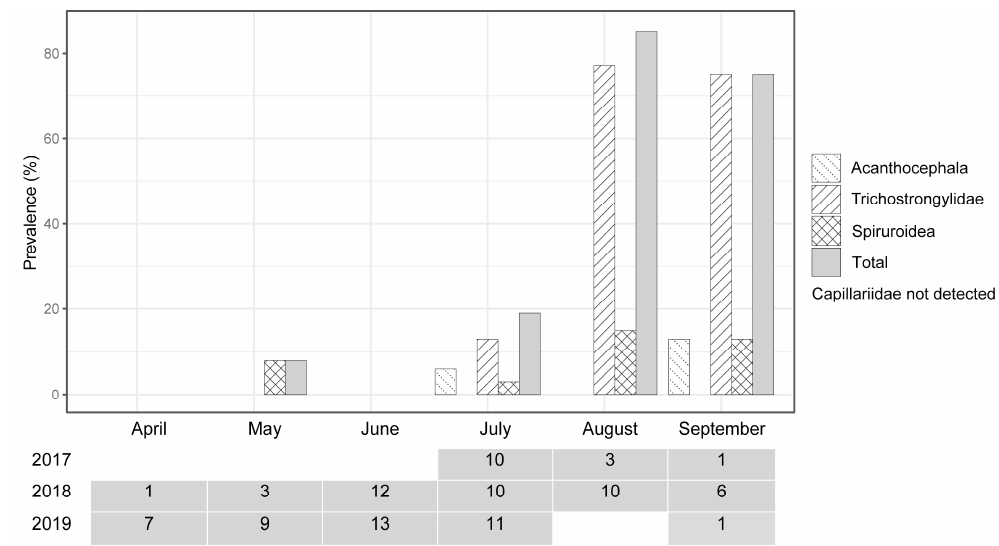
Figure 2. Seasonal dynamics for the studed period in the prevalence of the observed helminth taxa in the translocated individuals, summarized by month. Cells below the graph represent the period of sampling by month, with the corresponding sample sizes.